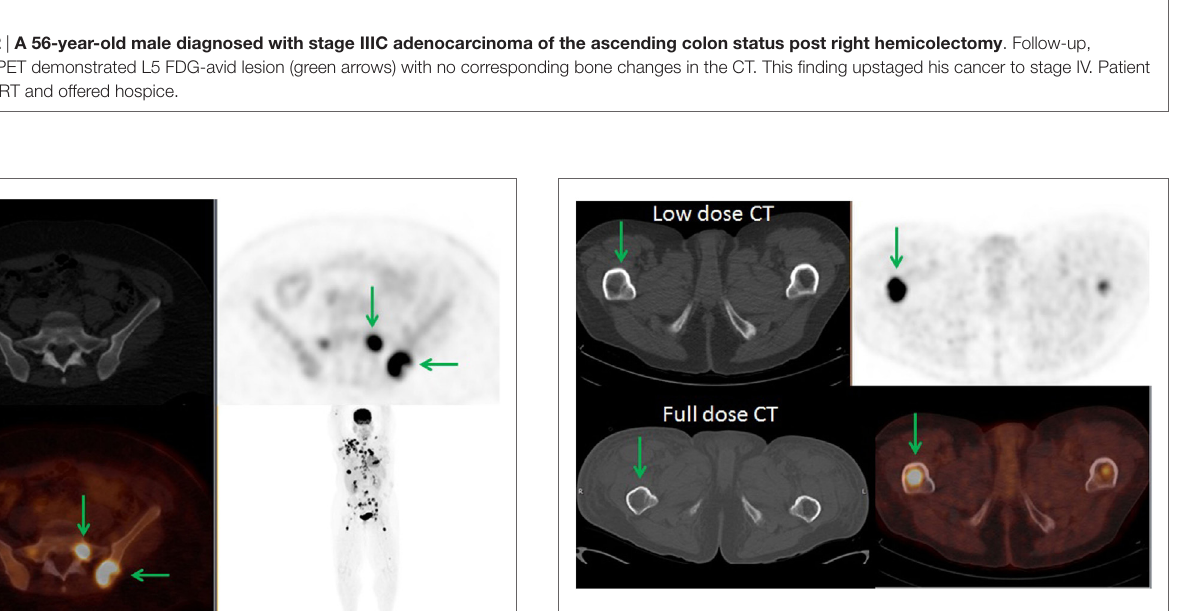
FigUre 4 | a 53-year-old male diagnosed with diffuse large B-cell lymphoma with multiple FDg-avid lesions above and below the diaphragm . There were PET-positive CT-negative femoral lesions (green arrows). Patient had a full dose CT which was negative for SM. There was no change in staging but XRT and BMA were